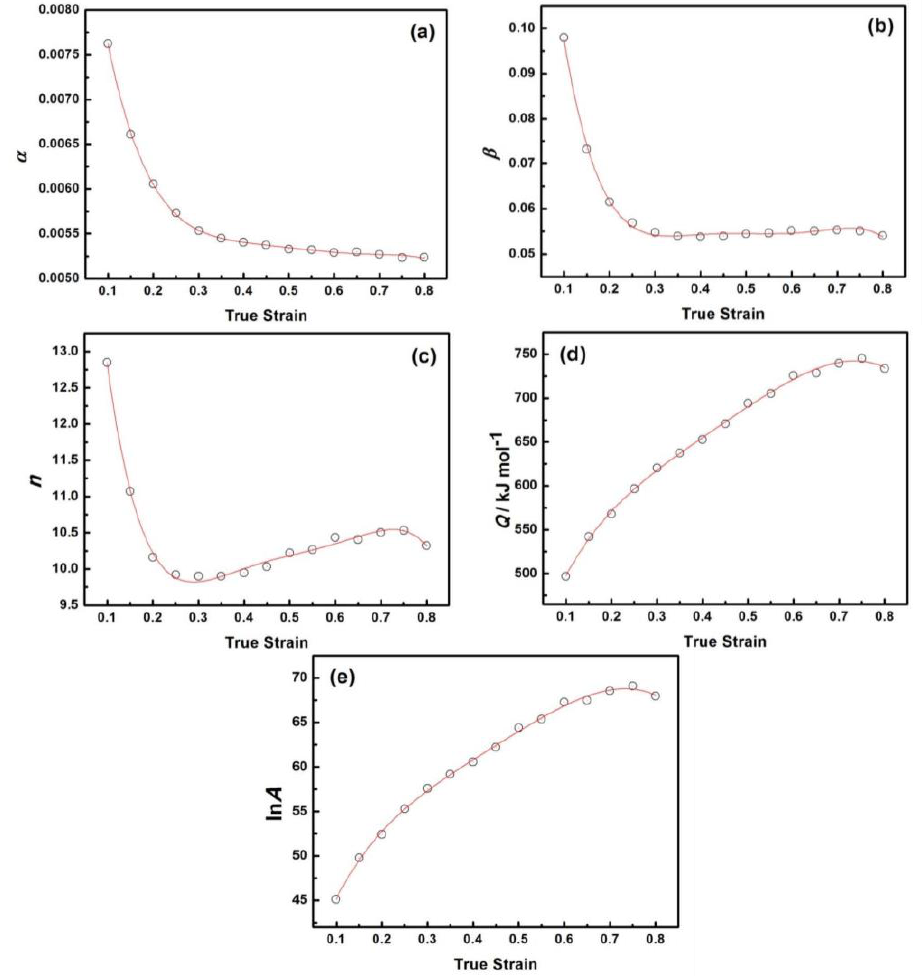
Figure 4. The variation of coefficients ( a ) α; ( b ) β; ( c ) n ; ( d ) Q ; and ( e ) ln A with true strain by polynomial